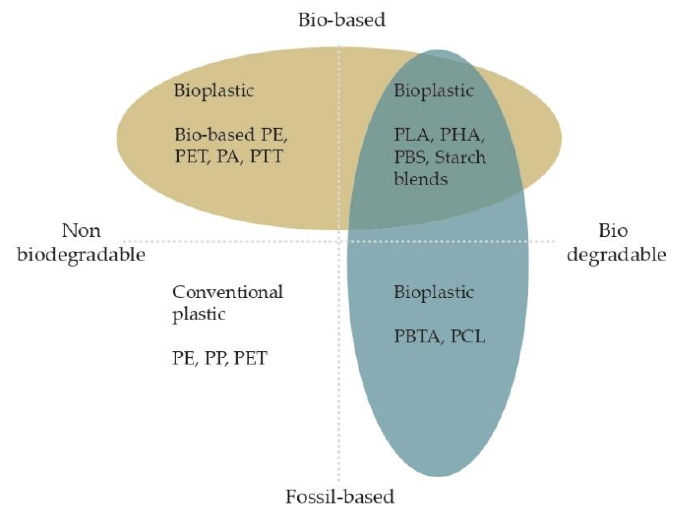
Figure 2. Classification of bioplastics according to European Bioplastics [9].